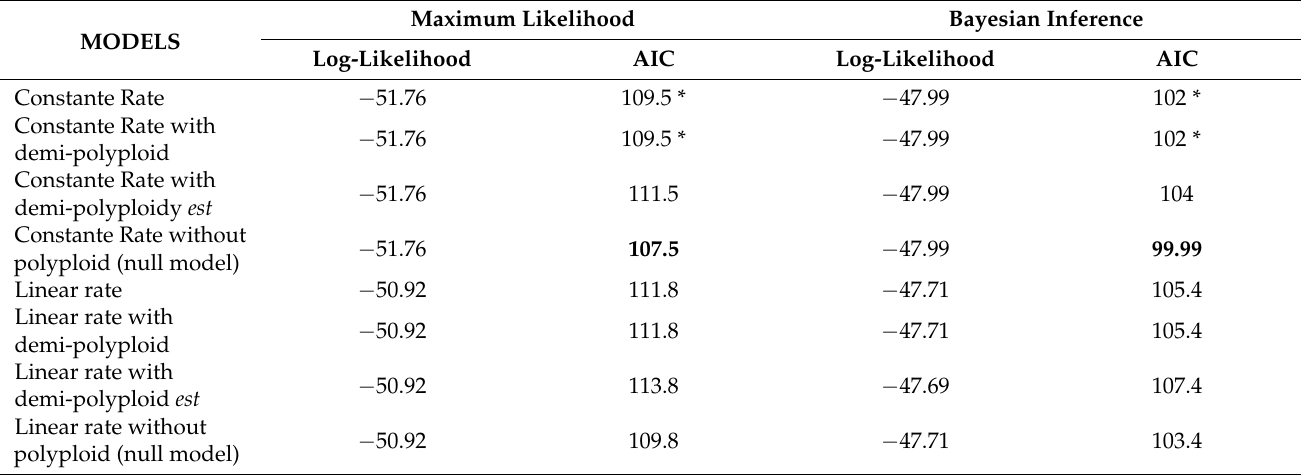
Table 2. ChromEvol model results to infer the ancestral base chromosome number and the chromo- some number changes in the tribe Sobraliinae. The analysis was carried out for Maximum Likelihood and Bayesian Inference phylogenetic trees. For each tested ChromEvol model for each phylogenetic method, the Log-likelihood and AIC values are presented. The lowest AIC in each phylogenetic tree is indicated in bold and * indicates alternative model that does not differ from the lowest